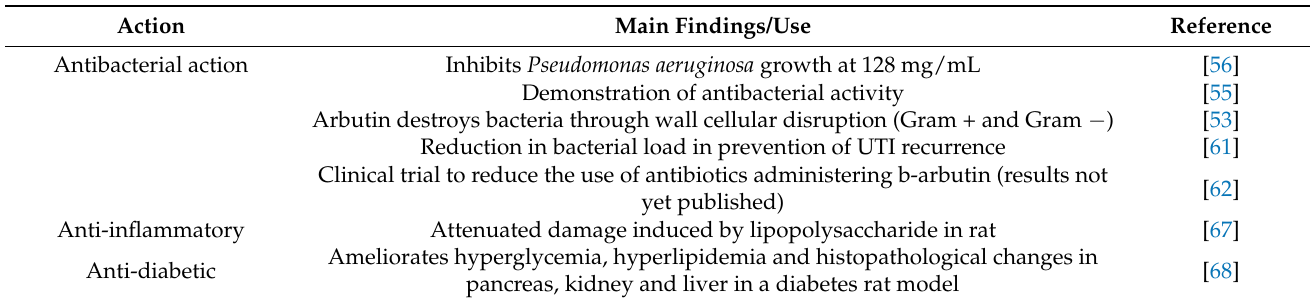
Table 3. Main actions of β